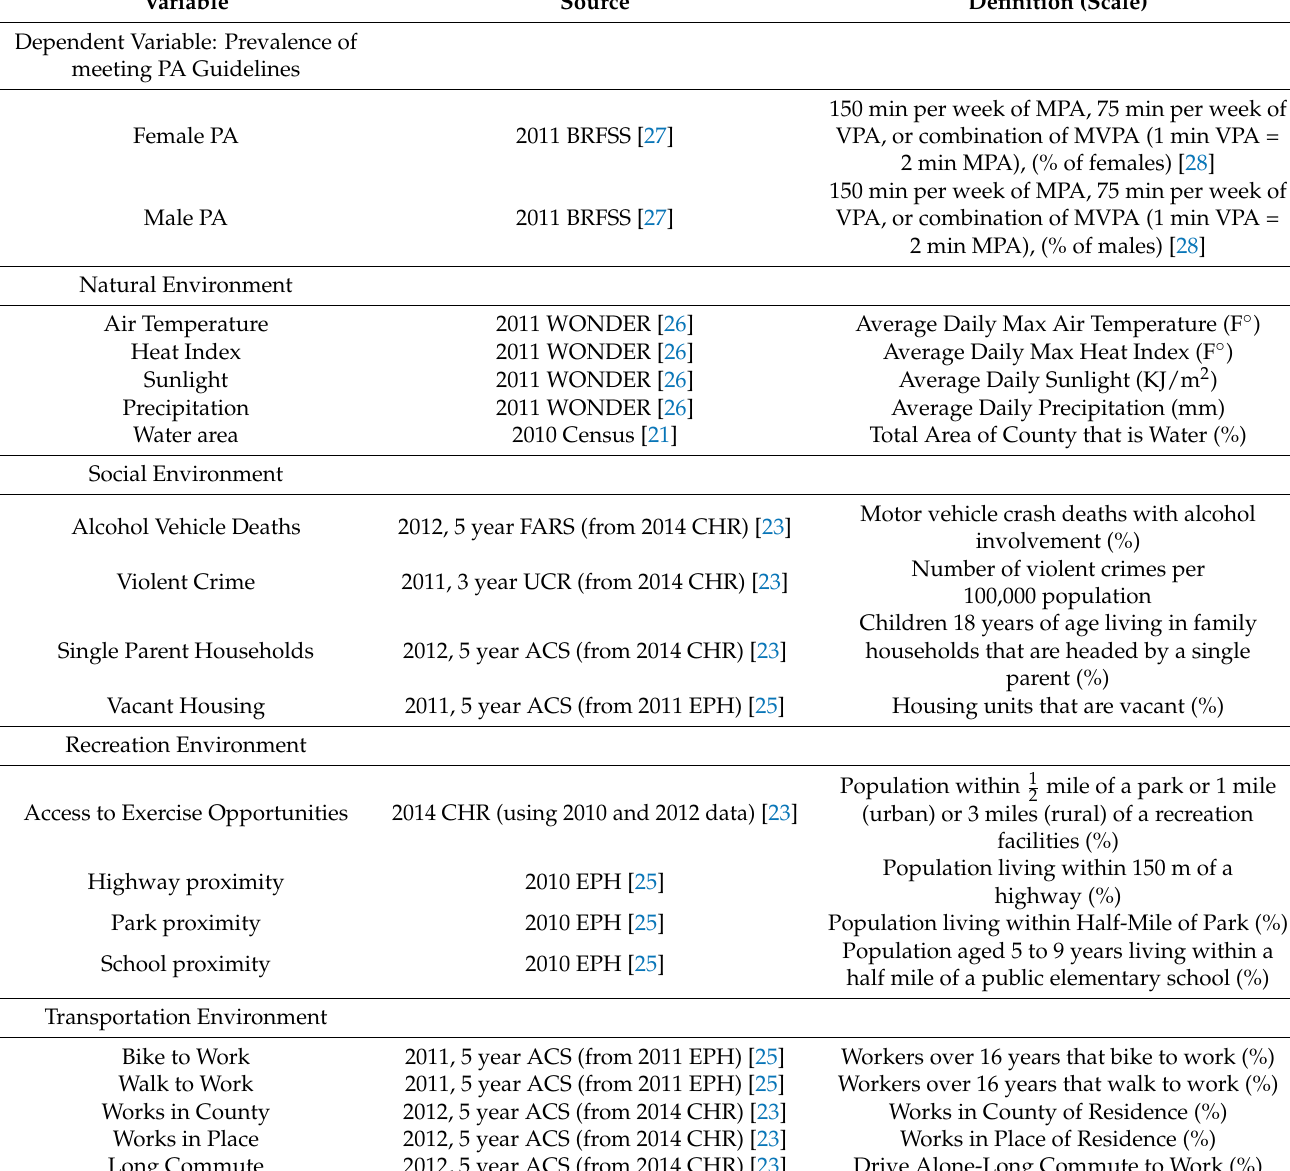
Table 1. List of Data Sources and Variables by Environment